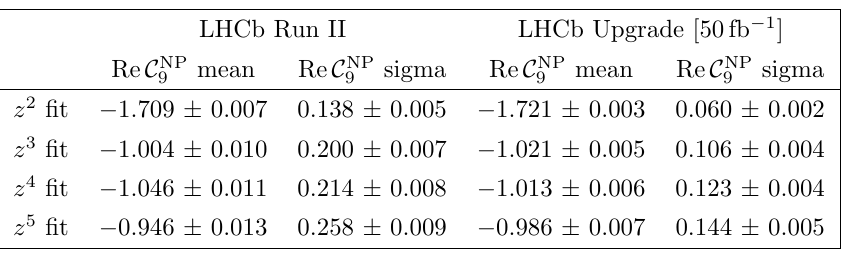
Table 3 . Expected central value and uncertainties for the C NP z 4 and z 5 (cid:12)ts for the BMP scenario when produced with non-zero z 3 coe(cid:14)cients as described in the